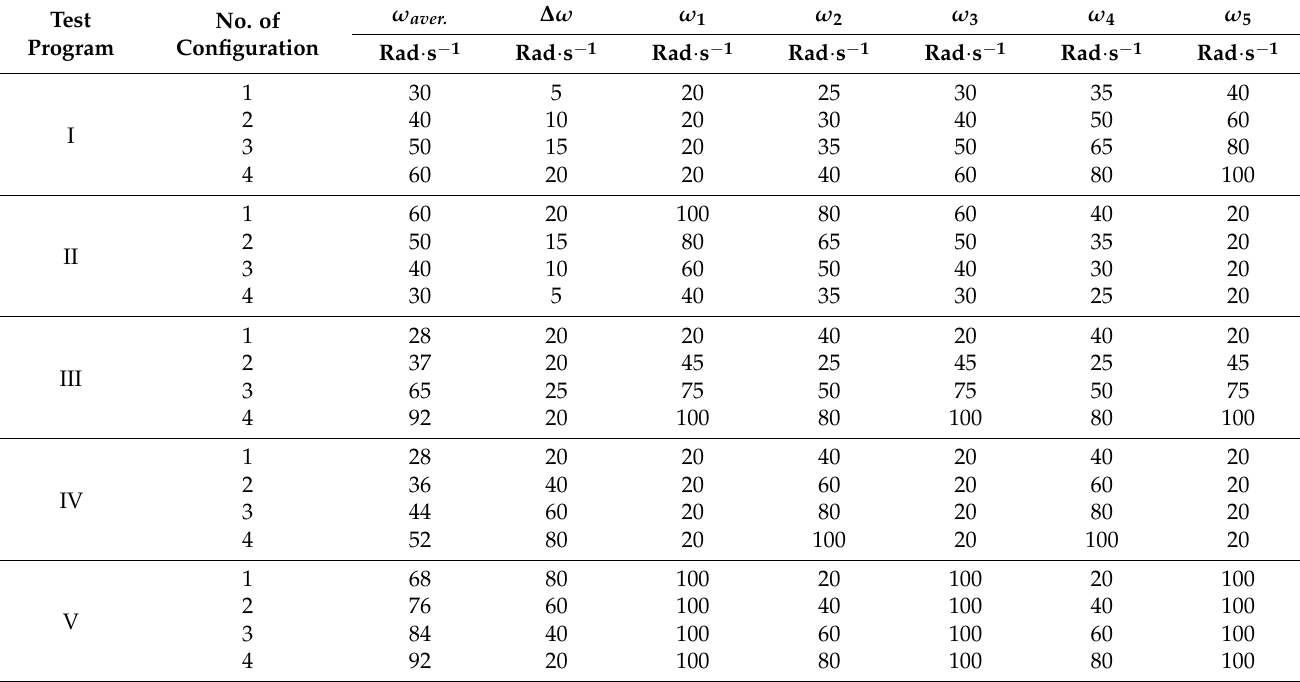
Table 2. Tested configurations of batch dosing speed and comminution disc velocities